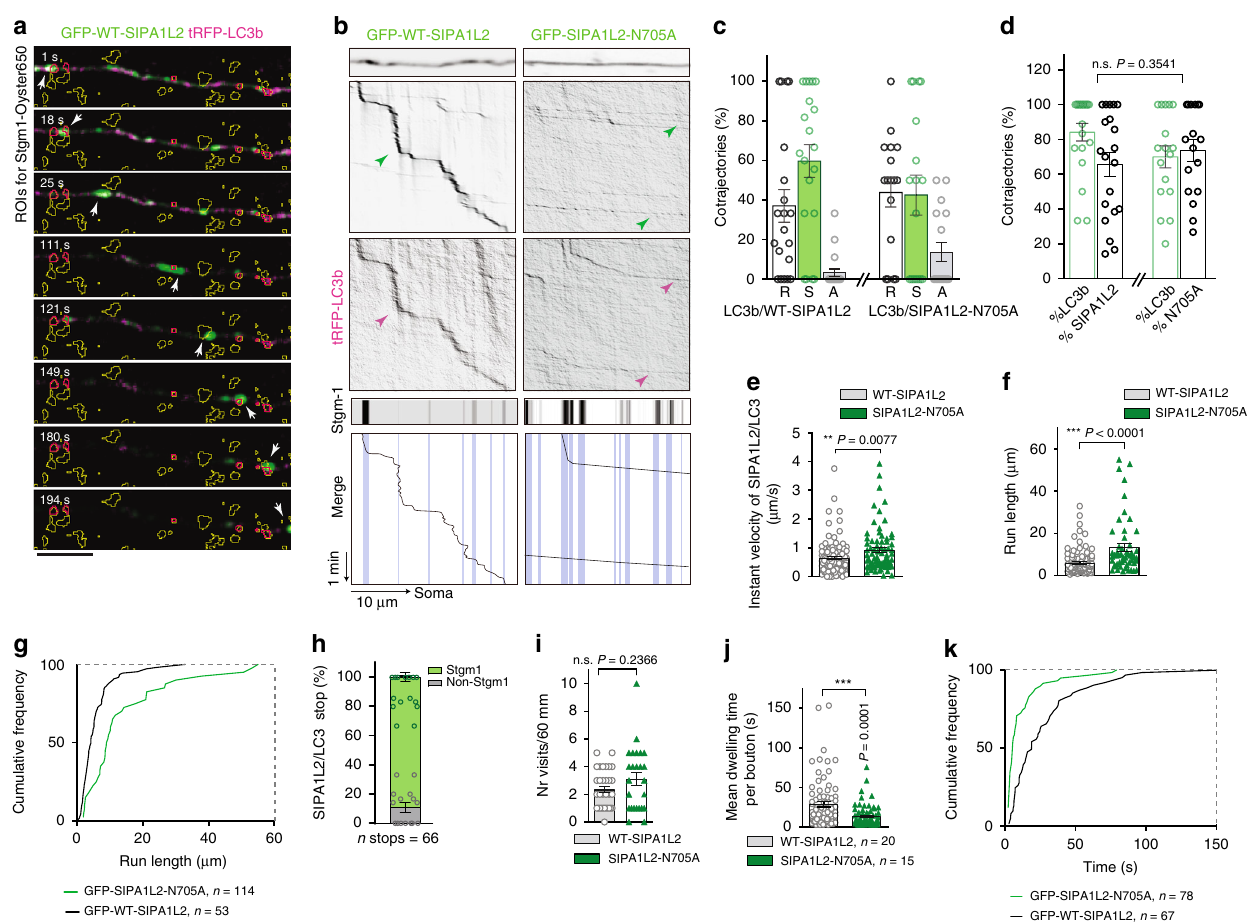
Fig. 5 The RapGAP activity of SIPA1L2 controls the motility of SIPA1L2-amphisomes. a Time-lapse representation of GFP-SIPA1L2/tRFP-LC3b visiting presynaptic boutons from rat primary hippocampal neurons live-labeled by Stgm-1 Oyster650 (yellow ROIs). Note that only ROIs in red are within the axon of interest and considered for analysis. Imaging was performed in conditioned neuronal media and three-channel time-lapse acquired for 5 min. Scale bar = 5 μ m. b Representative kymographs from the experiment described in a . Neurons expressed tRFP-LC3b and GFP-SIPA1L2 or GFP-SIPA1L2-N705A. Below, stationary Stgm-1 Oyster650 indicates presynaptic boutons. Sketch drawing represents traces of cotrajectories aligned with positions of presynaptic boutons (shaded blue lines). c , d Relative motility of SIPA1L2/LC3b and SIPA1L2-N705A/LC3b cotrajectories as percentage of total cotrajectories shows predominantly retrograde (R) movement (S, stationary; A, anterograde). In d , cotrajectories showed as a percentage of total LC3b or SIPA1L2 trajectories. Circles in bar graphs show values per analyzed kymograph (GFP-SIPA1L2: n = 20 axons, GFP-SIPA1L2-N705A: n = 17 axons). One-way ANOVA with Bonferroni ’ s posthoc test. e Instant velocity ( μ m/s) of GFP-SIPA1L2/tRFP-LC3b and GFP-SIPA1L2-N705/tRFP-LC3b cotrajectories. GFP-SIPA1L2: n = 102 instant measures from 20 axons; GFP-SIPA1L2-N705A: n = 77 instant measures from 14 axons. Mann − Whitney U test for the number of instant measures. f , g Quanti fi cation ( f ) and cumulative distribution ( g ) of the run-length; GFP-SIPA1L2: n = 114 measures from 20 axons; GFP-SIPA1L2-N705A: n = 53 measures from 14 axons (Mann-Whitney U test for the number of measures). h Percentage of LC3b/SIPA1L2 stopovers occurring in presynaptic boutons labeled by a Synaptotagmin 1 (Stgm1) antibody shows the preferential occurrence of these stopovers at boutons. Stops occurring outside Stgm1 labeling are depicted as non-Stgm1. Numbers of stops from 13 axons is depicted under the graph. i Average number of visited boutons in 60 μ m axon lengths of SIPA1L2/LC3b and SIPA1L2-N705A/LC3b vesicles. GFP-SIPA1L2: n vesicles = 21 from 20 axons; GFP-SIPA1L2-N705A: n vesicles = 21 from 14 axons cultures (Mann-Whitney U test for number of vesicles). j , k Mean synaptic dwelling time (GFP-SIPA1L2: n = 78 stops from 20 axons; GFP-SIPA1L2- N705A: n = 67 stops from 15 axons) calculated from imaging of neurons in conditioned neuronal media (Mann-Whitney U test for n of stops). Data in bar graphs are depicted as mean ± SEM. n.s. - not signi fi cant. "**" indicates P ≤ 0.01; "***" indicates P ≤